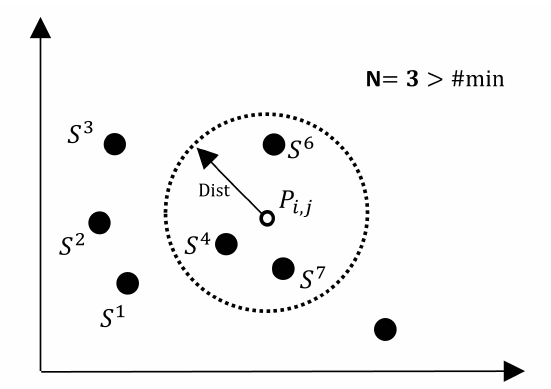
Figure 6. Comparison of a pixel value with a set of samples in a two-dimensional Euclidean color space. To classify P i , j , we count the number of samples of S i , j intersecting the sphere of radius Dist centered on P i , j